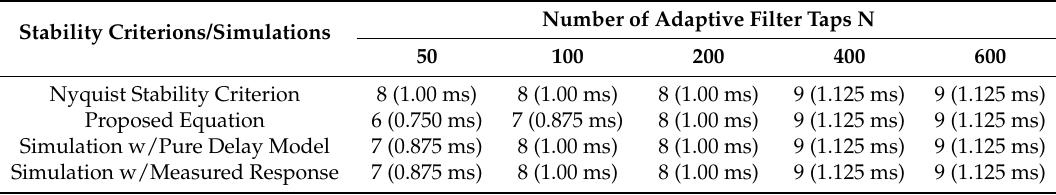
Table 1. The Stability Bounds of Delay error obtained for different number of adaptive filter taps. Stability Criterions/Simulations